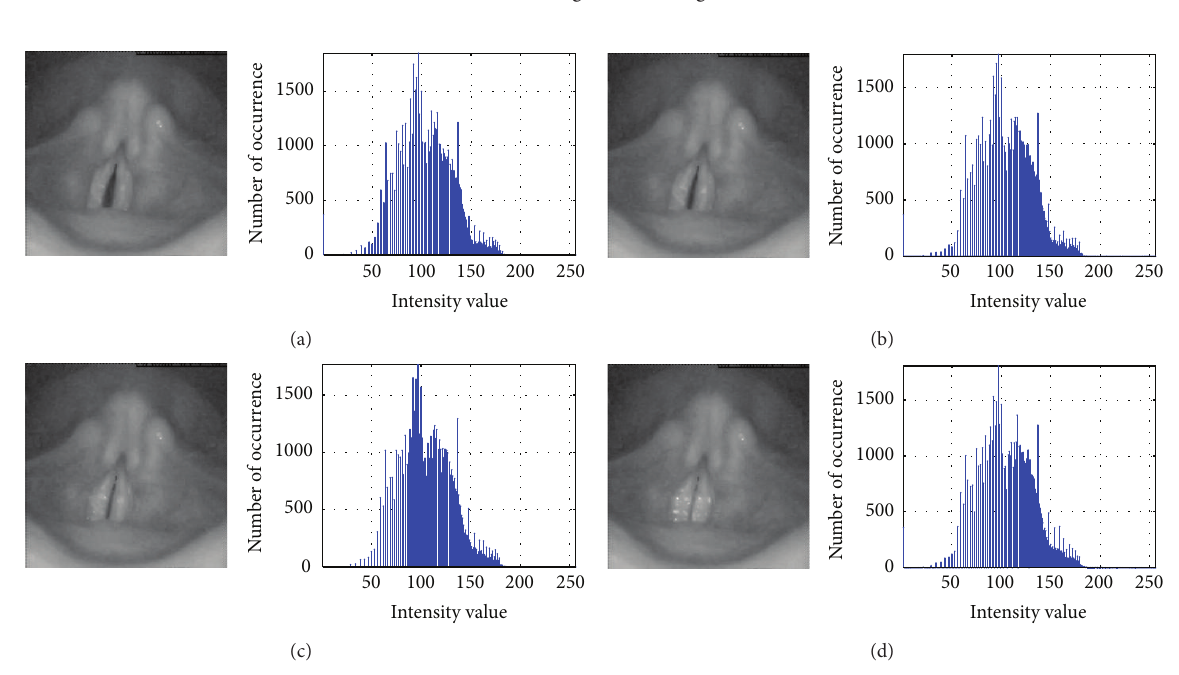
Figure 2: Four snapshots from HSV and corresponding